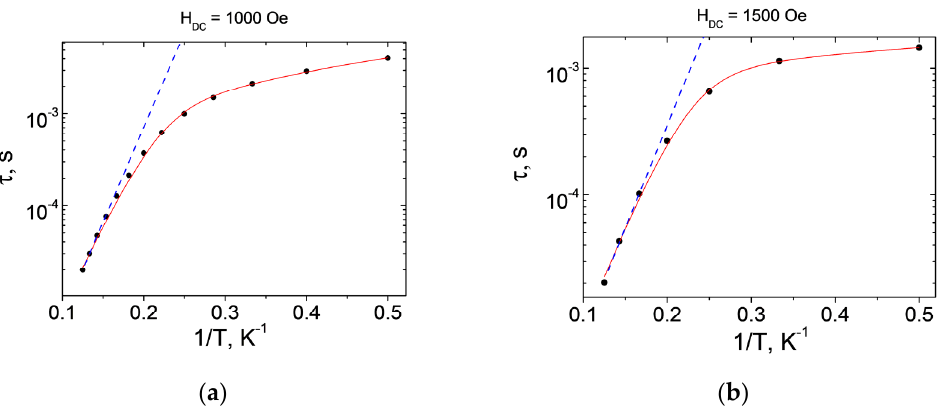
Figure 8. The τ (1/T) plots of the relaxation time of 1 ( a ) and 2 ( b ). Blue dashed lines—approximations of the high-temperature region using the Orbach relaxation mechanism; red solid lines—approximations using the sum of the Orbach and Raman mechanisms in the entire temperature range.